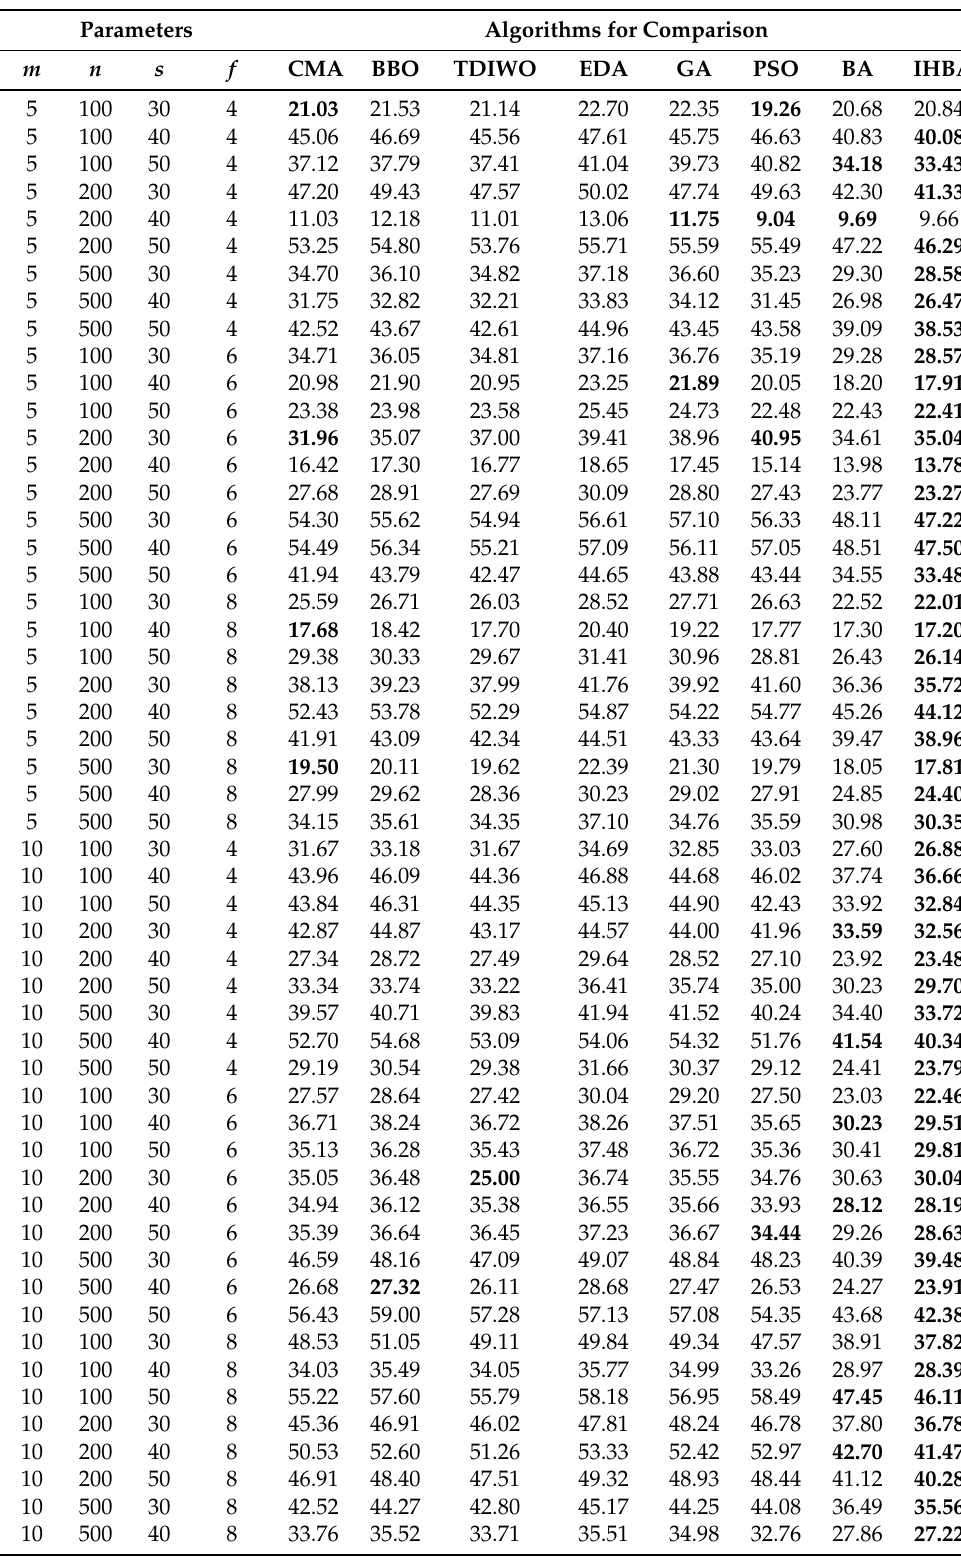
Table 10. The Average RPD Values at C = 60. It can be seen from the bold figures that the value of PRD of the proposed algorithm IHBA in this paper is smaller than that of other algorithms in the vast majority of combinatorial solutions, including the recognized TDIWO algorithm and the original bat